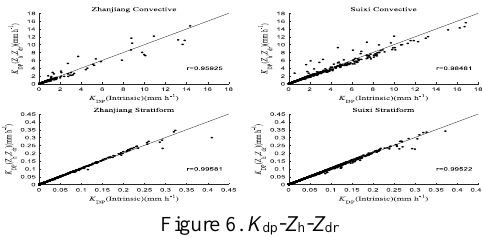
Figure 6. K dp - Z h - Z dr